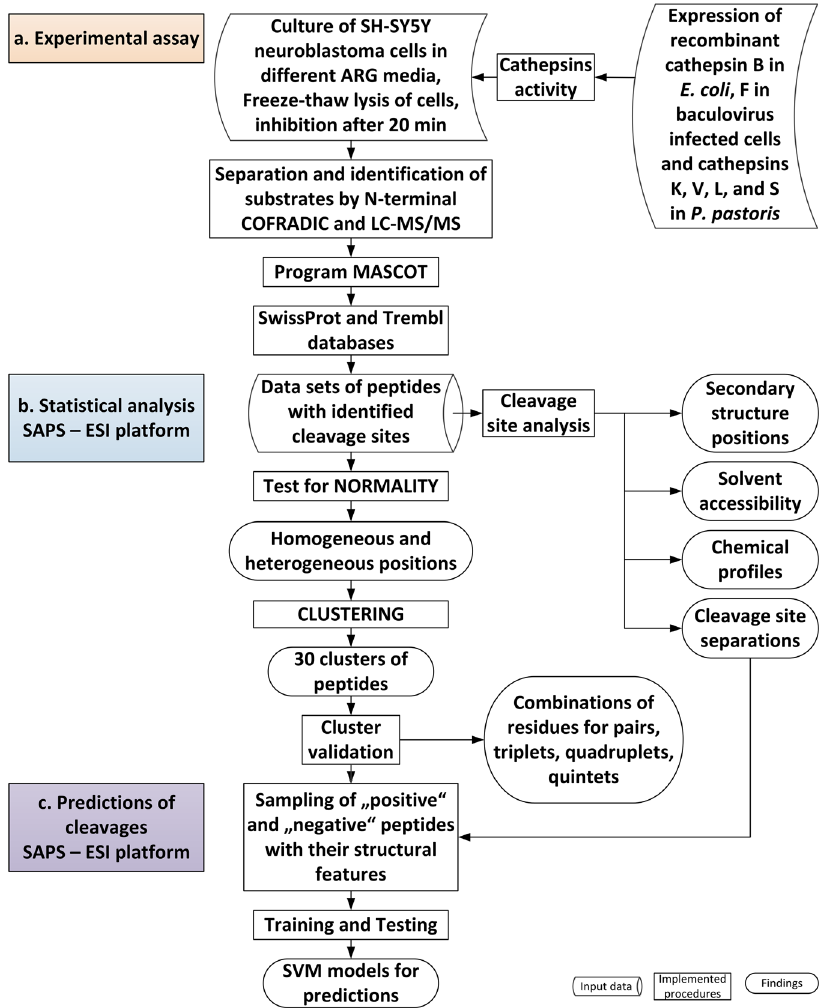
Fig. 1 Flowchart of the procedure. The procedure consisted of three steps: a Experimental assay, b SAPS-ESI statistical analysis, and c SAPS-ESI predictions, which are highlighted in a orange, b blue and c violet. SAPS-ESI platform was used in combination with MAIN program 59 and PCSS server 16